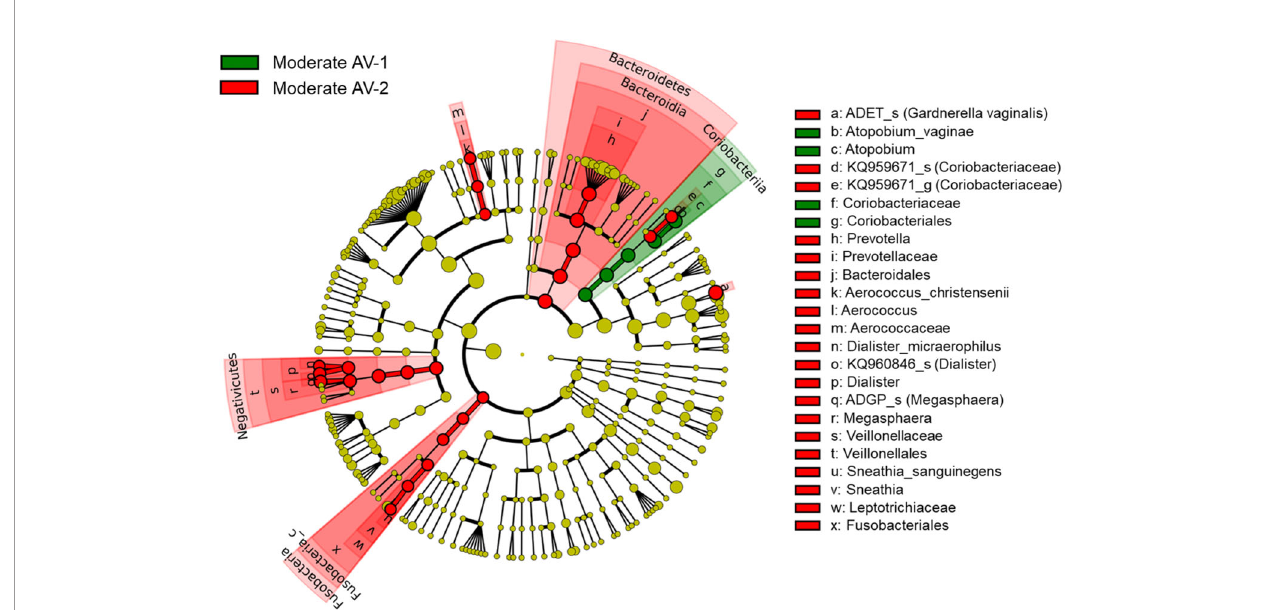
FIGURE 6 | The cladogram based on linear discriminant analysis effect size (LEfSe) of the moderate AV-1 (moderate AV without BV) and the moderate AV-2 (moderate AV with BV). Colors on the cladogram indicate the following: green (moderate AV-1) and red (moderate AV-2). Signi fi cantly abundant bacterial groups identi fi ed in this study are shown in the list on the right